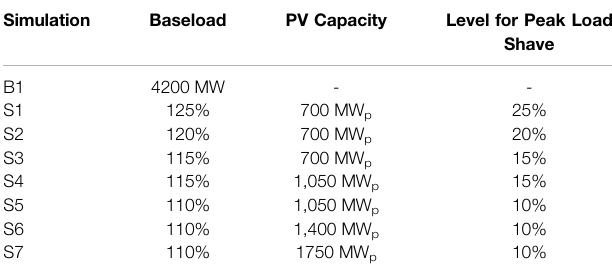
TABLE 2 | The design for numerical simulation. B1 run is the baseload run and therefore PV capacity and the level for peak load shave are not determined in the